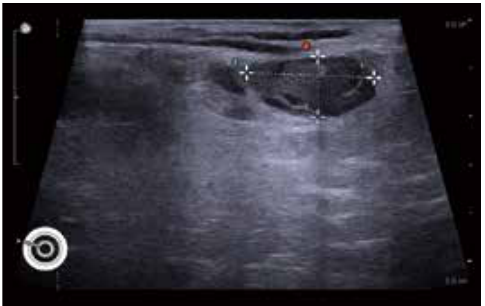
Figure 1 TRUS image of sagittal view at 9~10 o’clock position. The abscess in the intersphincteric groove at the middle and low level of the anal channel was seen as a hypoechoic lesion with a measurement of 2.63×1.24 cm.